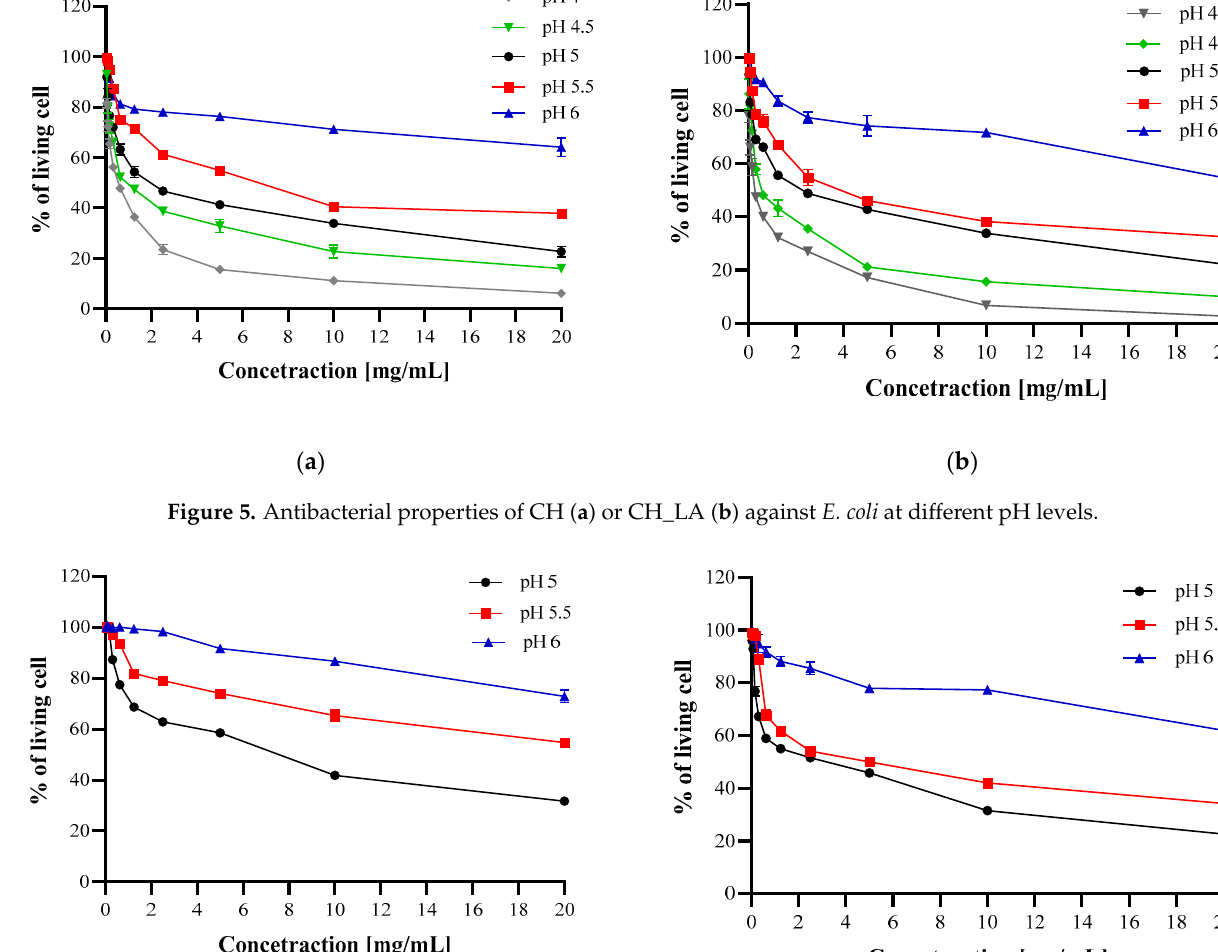
( b ) Figure 4. Antibacterial properties of CH ( a ) and CH_LA ( b ) against S. aureus at different pH. As can be observed in Figure 4 at the highest concentration (20 mg/mL) the percentage of living S. aureus cells is on a similar level for both materials at all pH values (Table S1).